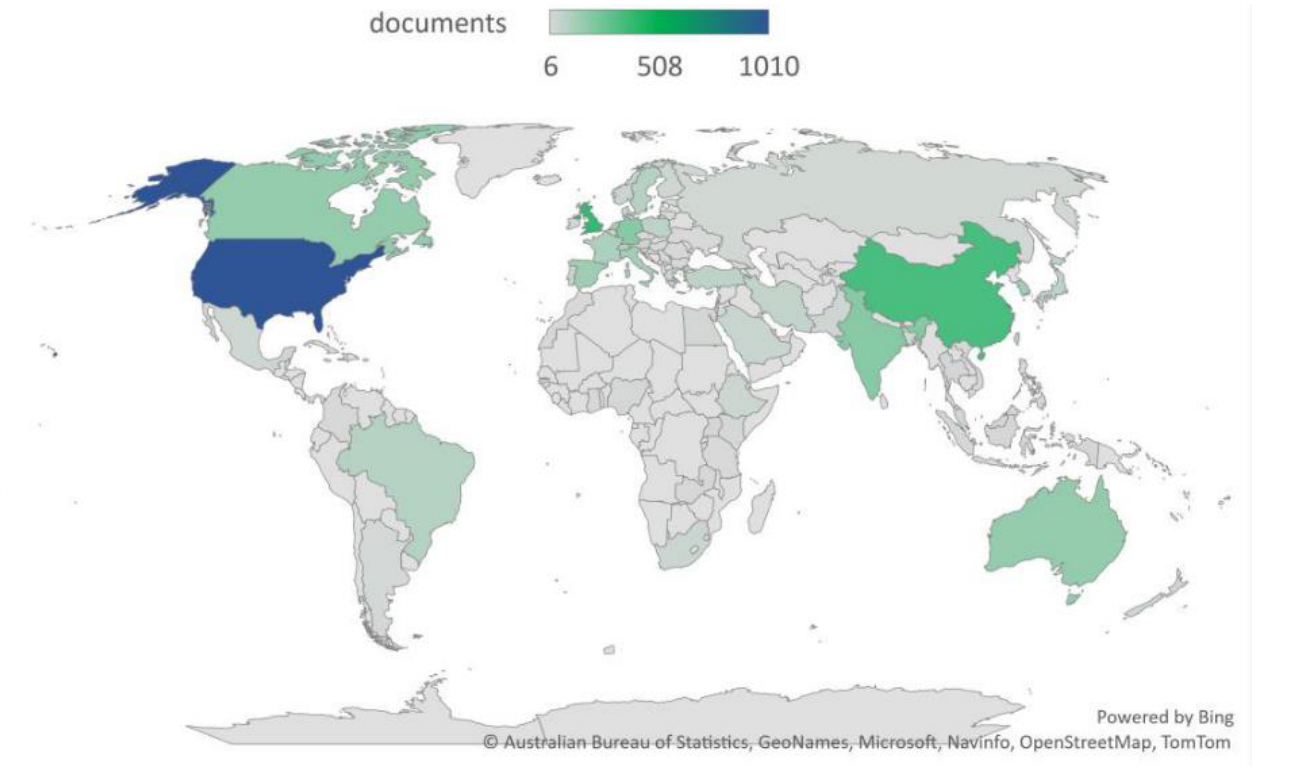
Figure 3. Distribution of documents based on AI implications on health across the globe. Source: Australian Bureau of Statistics, GeoNames, Microsoft, Navinfo, OpenStreetMap, TomTom.